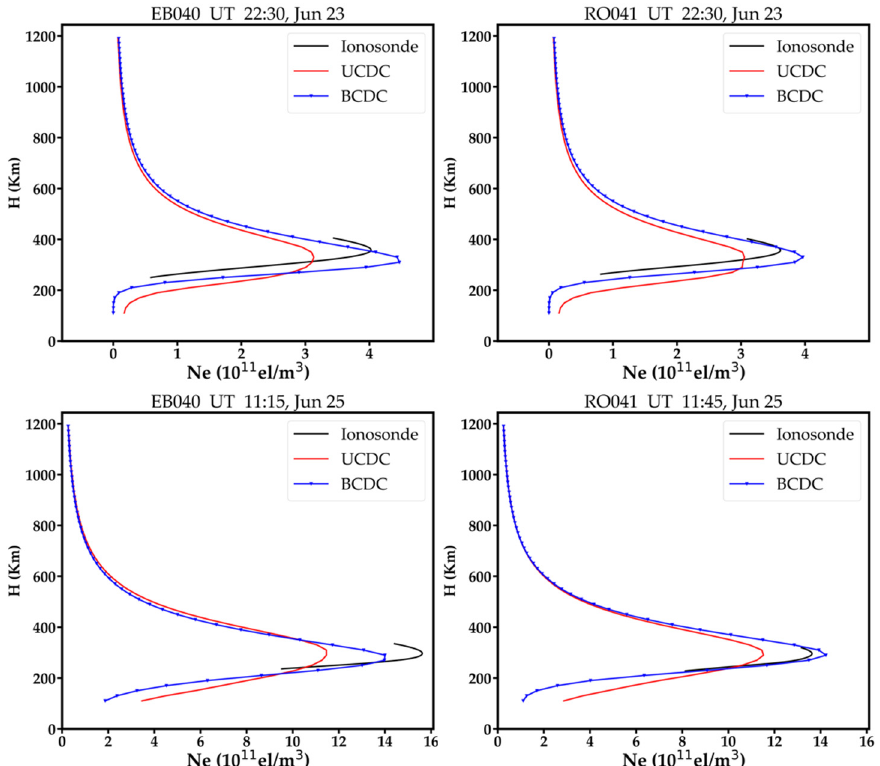
Figure 13. Vertical profiles obtained by the BCDC and the UCDC at EB040 station (left column) and RO041 station (right column), respectively.